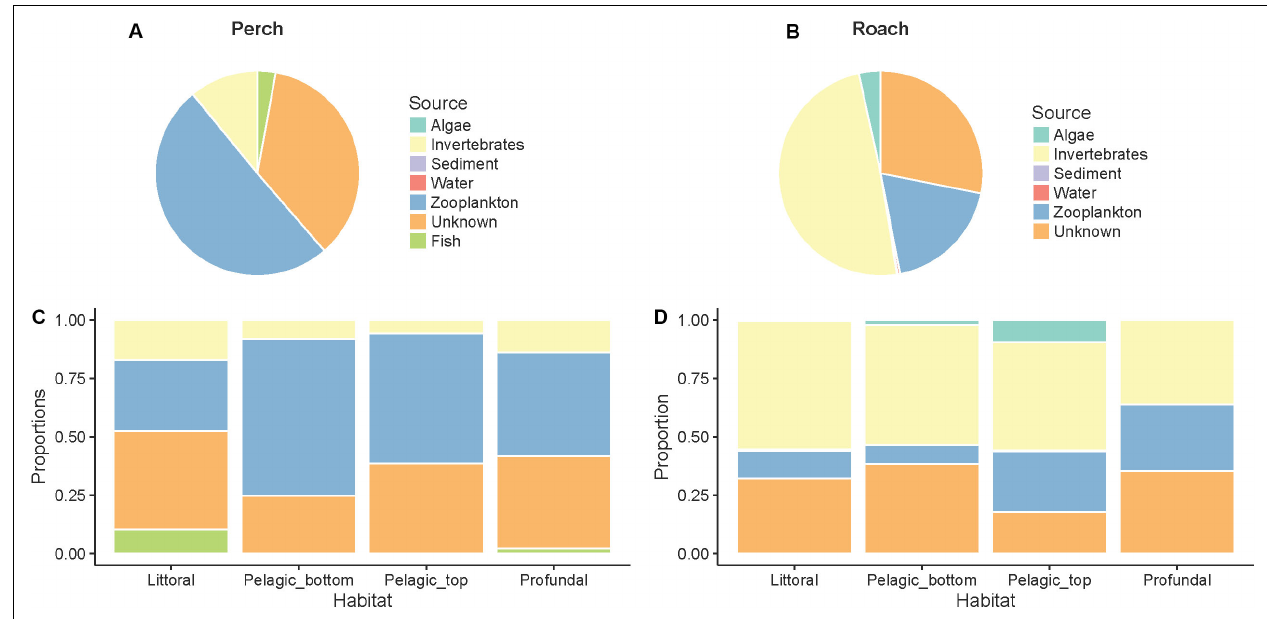
FIGURE 4 | Contributions of microbes from different dispersal sources to intestinal microbial communities as determined by SourceTracker analysis. In perch (A) and roach (B) across habitats in perch (C) and across habitats in roach (D)